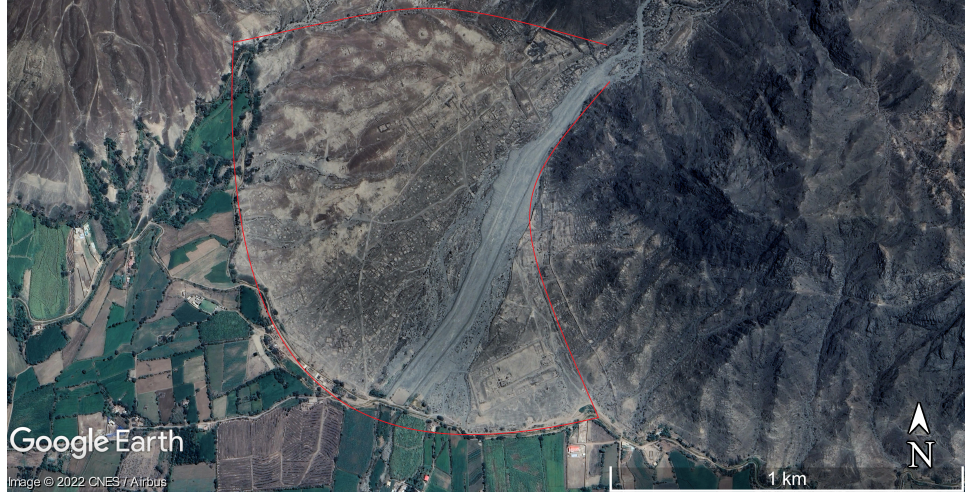
Figure 3. Caballo Muerto Archaeological Complex; 2021 satellite image (8 ◦ 03 (cid:48) 59 (cid:48)(cid:48) –8 ◦ 04 (cid:48) 53 (cid:48)(cid:48) S, 78 ◦ 55 (cid:48) 19 (cid:48)(cid:48) –78 ◦ 53 (cid:48) 44 (cid:48)(cid:48) W). The alluvial fan on which lies the main settlement of the complex is marked by a red line. Its stratigraphy should contain a wealth of data regarding El Niño events (see